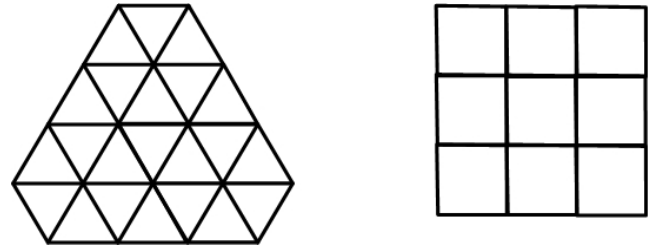
Figure 3. Structure of α - grids : regular triangle and square.